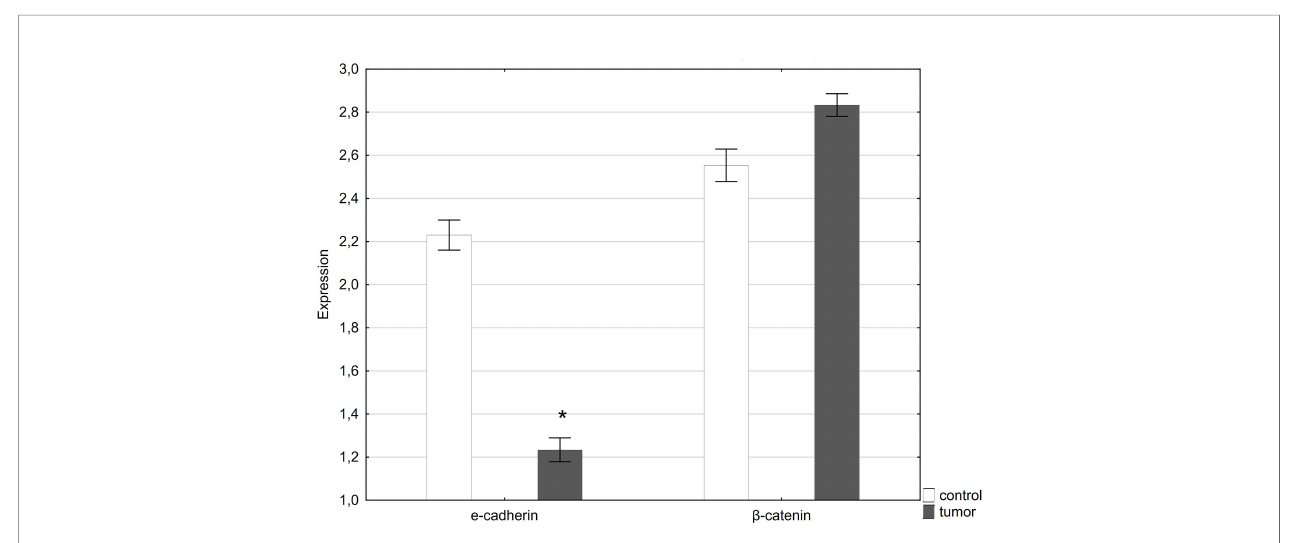
FIGURE 4 | Expression of E-cadherin and b -catenin in normal penile tissue (control) and penile tumor. *p < 0.05 was considered signi fi cant.